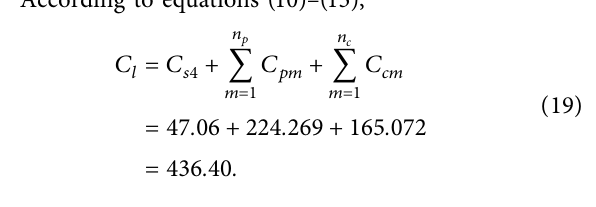
According to equations (10)–(13),